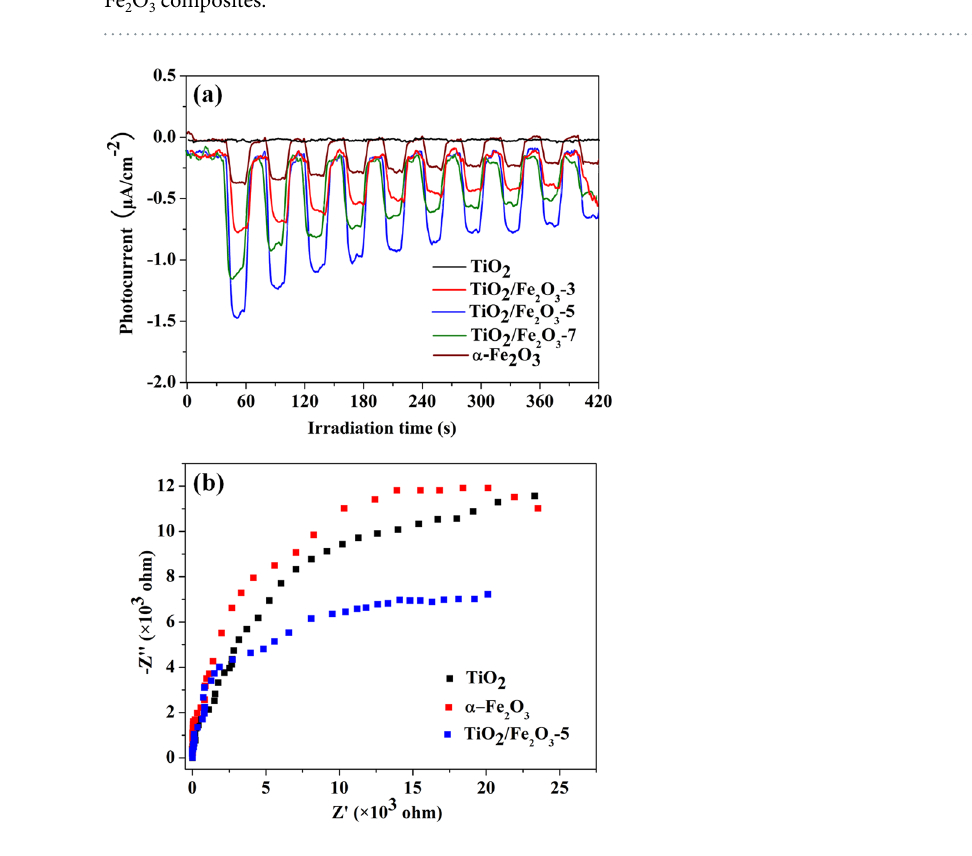
Figure 6. ( a ) Transient photocurrent response of TiO 2 , α -Fe 2 O 3 and TiO 2 /Fe 2 O 3 composites in 0.2 M Na 2 SO 4 aqueous solution under irradiation of visible light ( λ ≥ 420 nm); ( b ) Nyquist impedance plots of TiO 2 , α -Fe 2 O 3 and TiO 2 /Fe 2 O 3